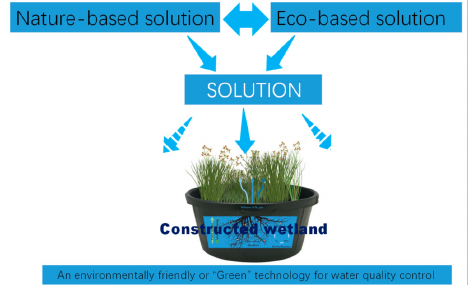
Figure 4. Constructed wetland is the core technique of nature-based solutions in water pollution